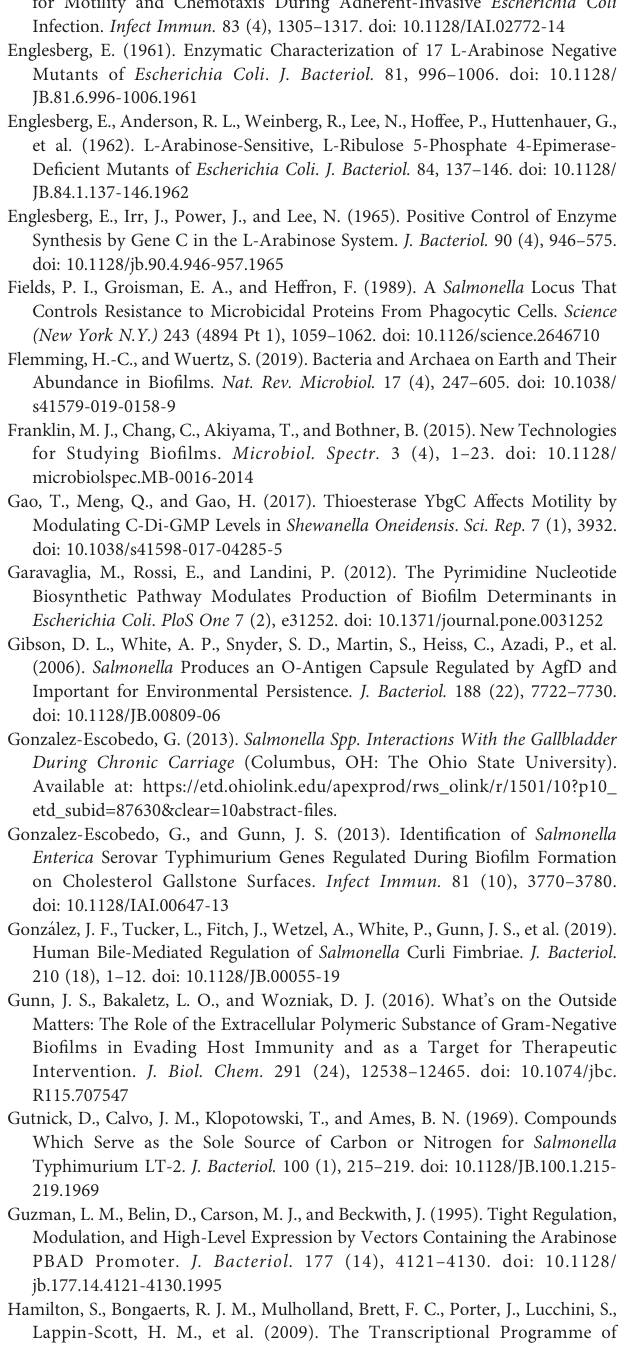
Supplementary Figure 2 | L-arabinose also effects bio fi lm formation in M9. (A) WT 14028, D araA and D araE strains were grown in 96-well plates in 100 µL M9 supplemented with varying concentrations of L-arabinose. The concentrations are in mM noted in parentheses. After 24 hours, planktonic cells were removed, then bio fi lms were washed, heat fi xed, and stained with crystal violet (CV) for relative bio fi lm measurement as determined at OD 570 . (B) WT 14028 and D araE were grown in 96-well plates in 100 µL M9 supplemented with 5 mM or 40 mM L-arabinose. OD 600 was measured every 30 minutes for 24 hours.